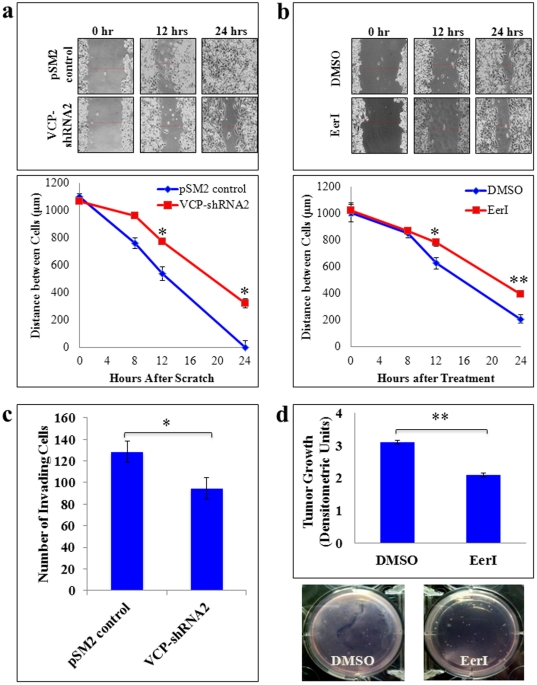
VCP inhibition retards the migration, invasion and growth of NSCLC.H1299 cells were either (a) transfected with pSM2 control vector or VCP-shRNA or (b) treated with EerI or DMSO, followed by scratch assay to quantify changes in cell migration. Briefly, a scratch was made across the center of the confluent monolayer using a 10 µl pipette tip. The cells were allowed to migrate and were monitored at the indicated time points using a Nikon light microscope and Infinity Capture Software. The representative images show that both VCP knockdown and inhibition visibly slowed H1299 migration into the scratch by 12 and 24 hours (top panels). Changes in the average width of the scratch were calculated using Infinity Analyze Software (mean ± SEM; n = 3–4). Quantitative analysis show that both VCP knockdown and functional inhibition significantly retarded cell migration at 12 and 24 hours (bottom panels, * p<0.05; ** p<0.0005). (c) H1299 cells were transfected with pSM2 or VCPshRNA2 for 24 hours and transferred to transwell inserts (BD, 0.4 µm pores) coated with 200 µg Matrigel basement matrix for additional incubation for 24 hours. Following incubation, cells that had migrated to the bottom of the membrane were stained with trypan blue solution and the central field of each insert was visualized using a Nikon light microscope (n = 4, mean ± SEM given). The data shows that VCP inhibition significantly reduced the number of invading cells as compared to the controls. (d) H1299 cells (4.0×105 cells/well) were suspended in 2 mL of serum-containing medium with agarose (0.3%) and immediately plated over a layer of solidified agarose (2-mL, 0.6%) on a 6-well plate (n = 3). No cells (Blank) and untreated H1299 cells were used as controls. Fresh media containing either EerI (10 µM) or DMSO (vehicle) was added on top. After 48 hrs, the images were captured and analyzed using the Adobe Photoshop Software. Representative images and densitometry data (mean ± SEM) shows the significant decrease in number of colonies and H1299 cell invasion in agarose by EerI treatment as compared to the DMSO treated controls. VCP mediates NSCLC migration, invasion and growth that suggest its critical role in tumor cell progression and metastasis.